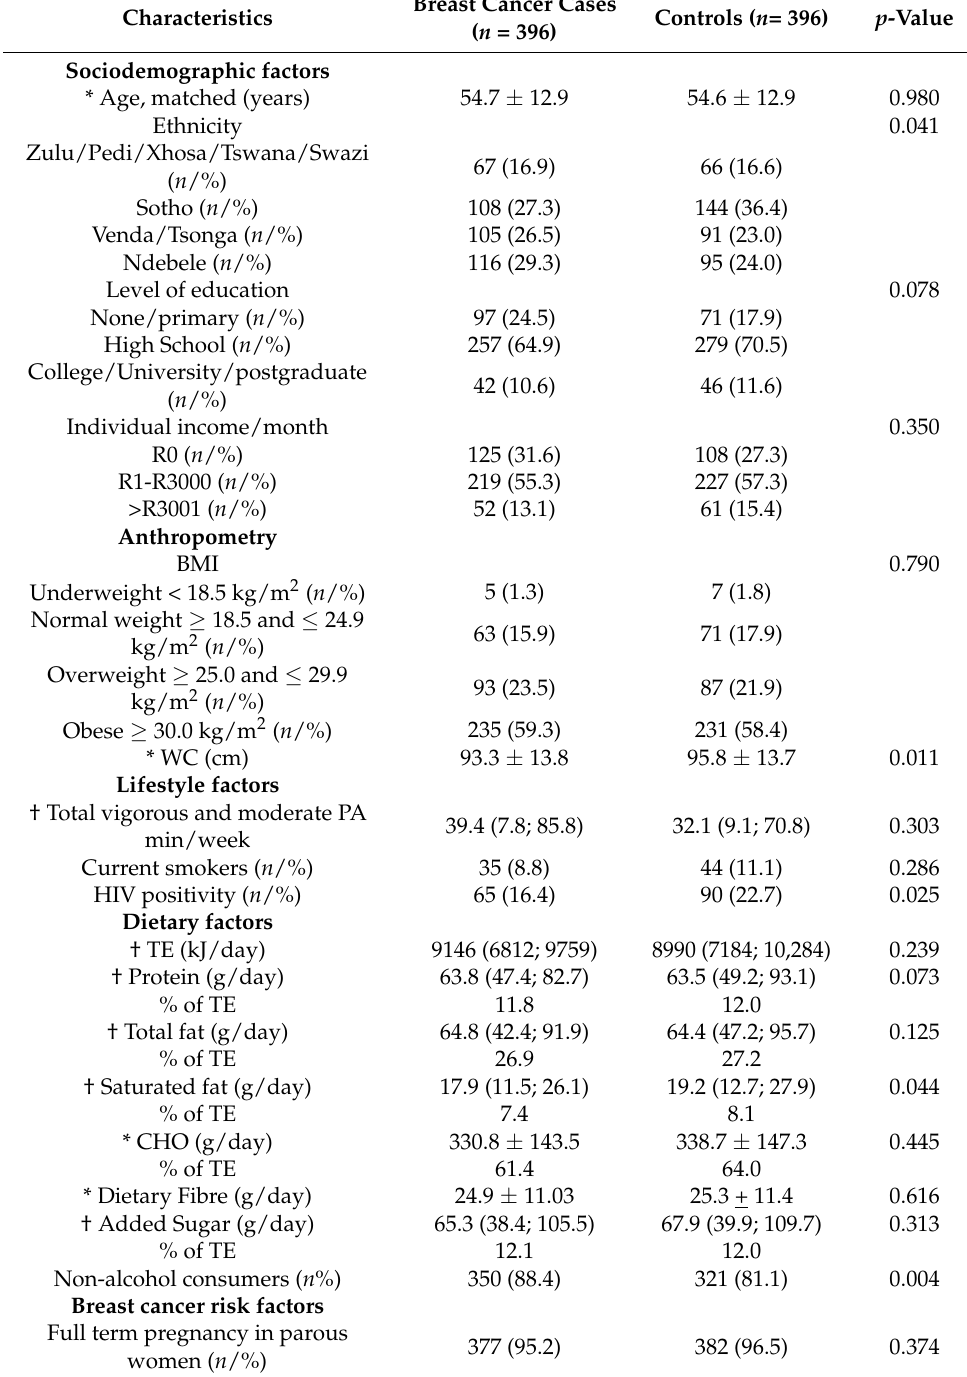
Table 1. Selected characteristics of the study participants by case–control status (means ± standard deviations for parametric data, median and 25th; 75th percentiles for nonparametric data and n (%) for categorical